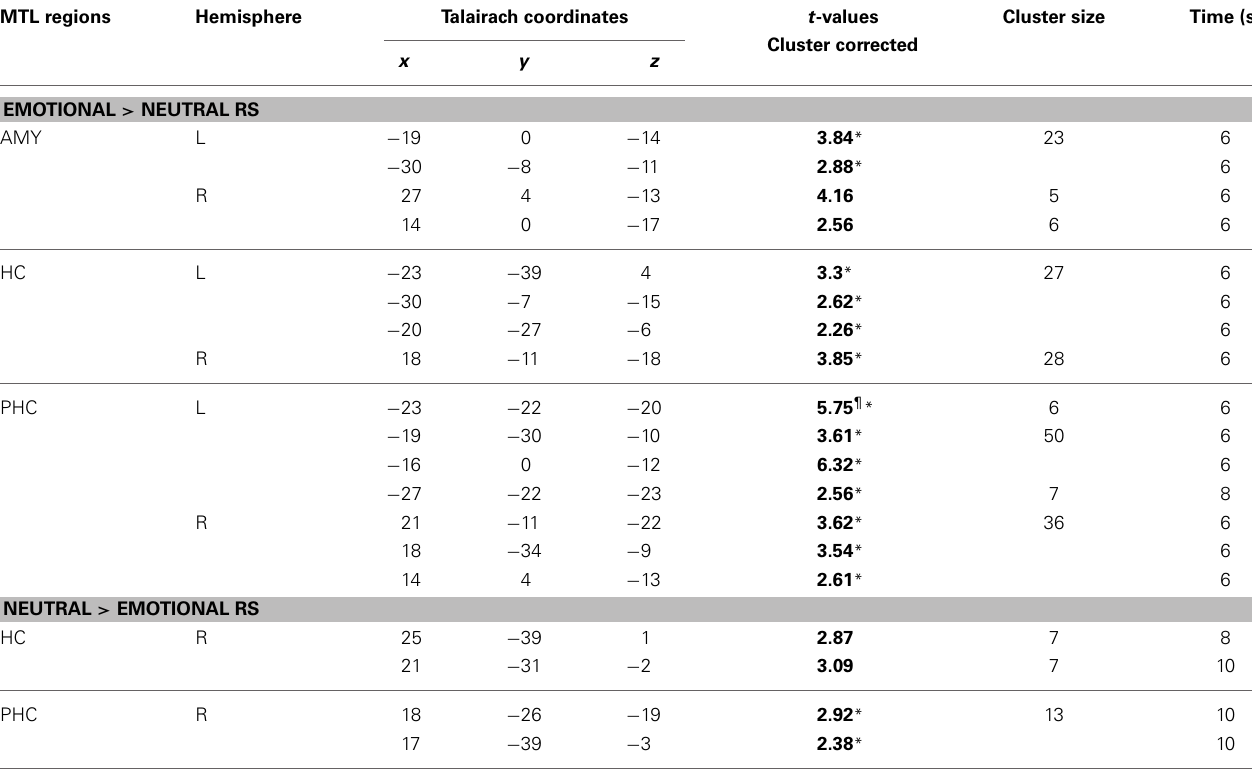
Table 2 | MTL regions specifically engaged in emotional vs. neutral retrieval success activity. MTL